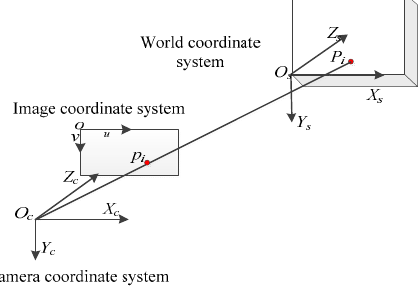
Figure 1. Camera model.